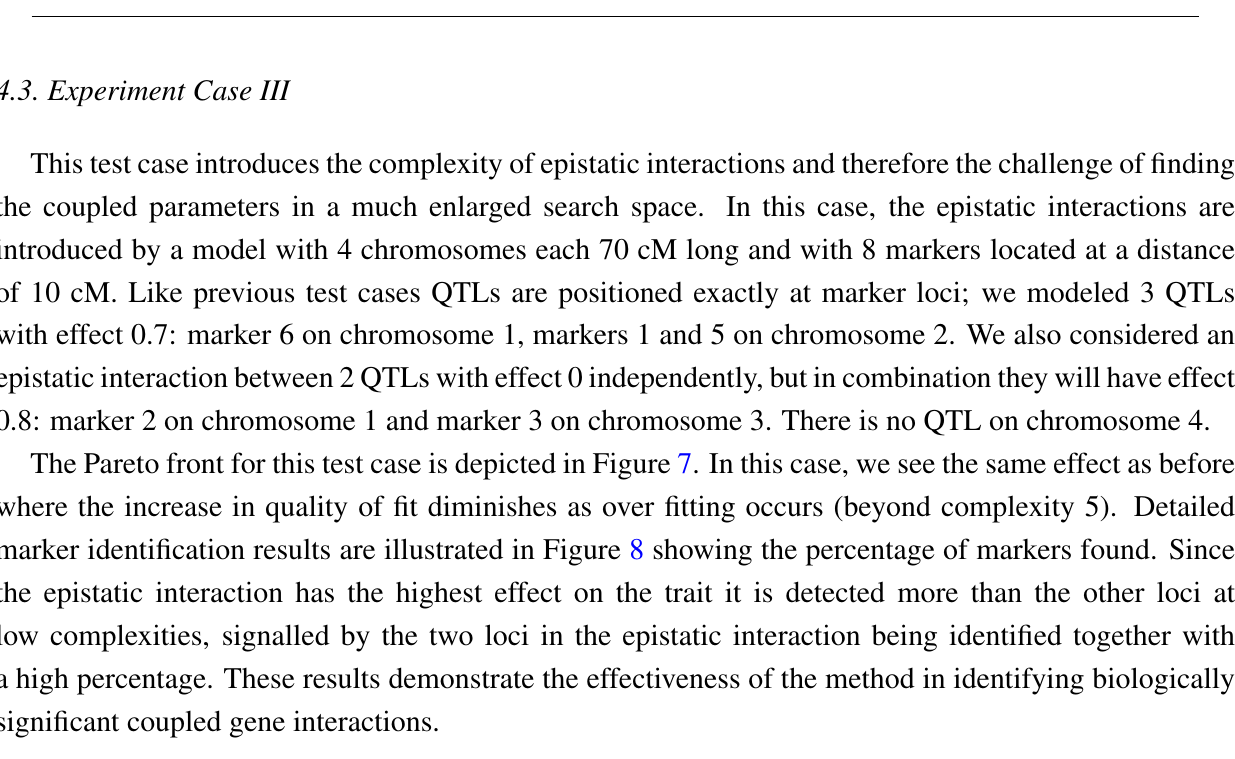
Figure 7. Case II Pareto Front: showing the relation between − R 2 and complexity for Case III. The values are average of 10 runs of 100 simulation